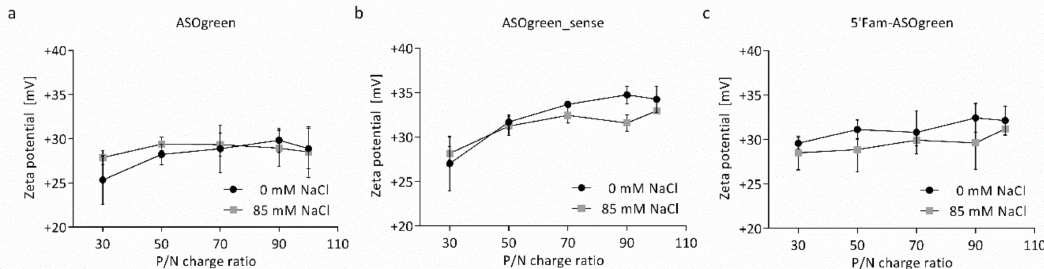
Figure 3. The zeta potential of CS–ASO nanocomplexes at varying P / N charge ratios. The zeta potential of CS–ASO nanocomplexes with ( a ) ASOgreen, ( b ) ASOgreen_sense and ( c ) 5 (cid:48) Fam-ASOgreen increased with increasing P / N charge ratio. On average, nanocomplexes prepared in the presence of 85 mM NaCl had a lower zeta potential than nanocomplexes prepared without NaCl ( n = 3).